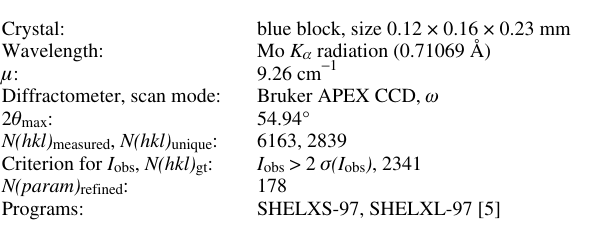
Table 1. Data collection and handling.